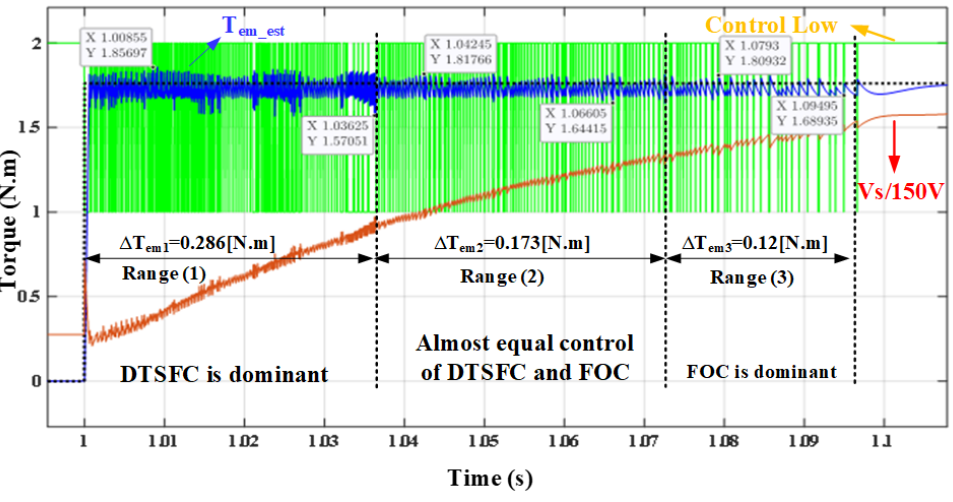
Figure 26. Testbed behaviour of torque response within the transient state in the proposed